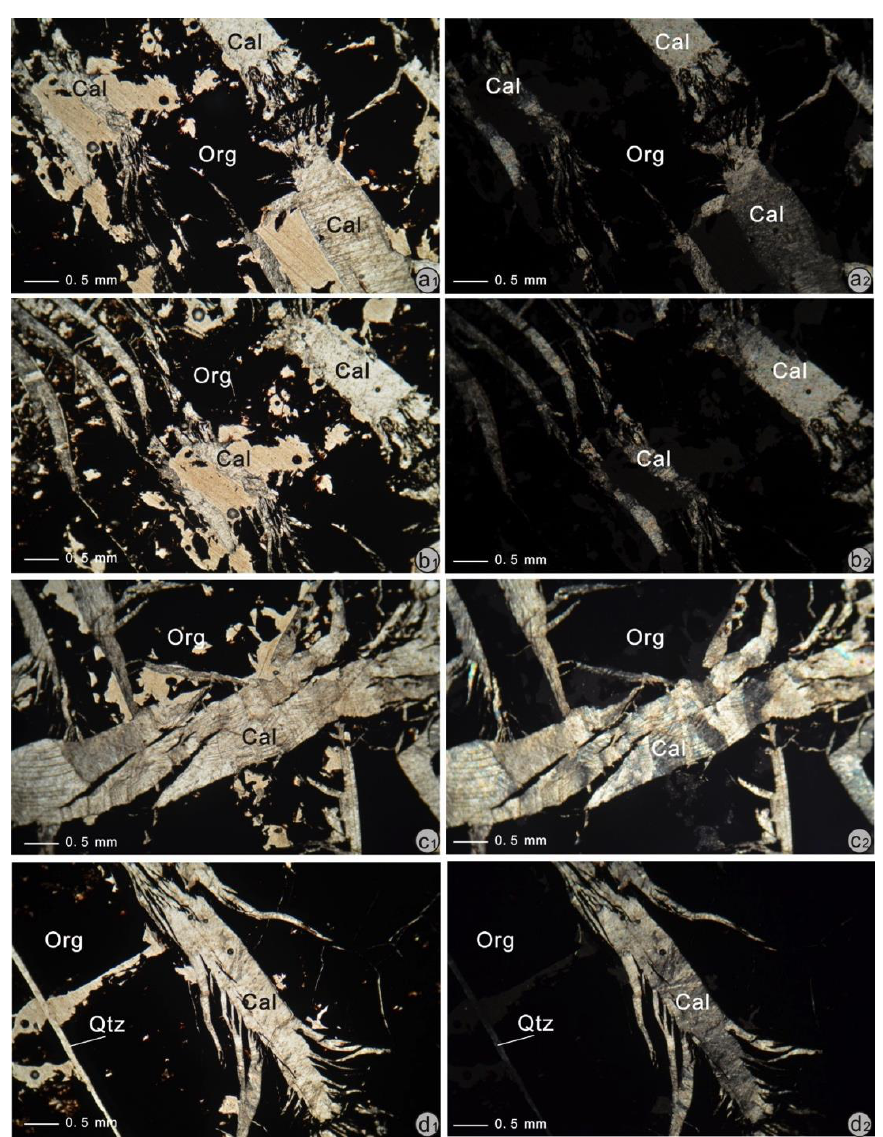
Figure 5. Vein-like calcite and quartz of the infilling mineral matter (IMM) under polarized light ( a 1 , b 1 , c 1 and d 1 ) and crossed polarizer light ( a 2 , b 2 , c 2 and d 2 ) of cleated structural coal from the No.3 coal